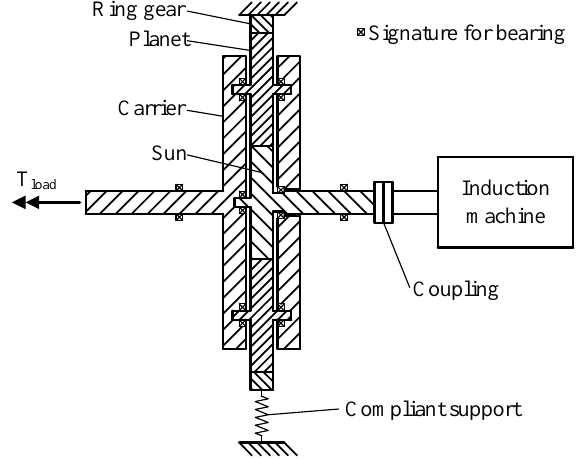
Figure 1: Considered system consisting of induction machine, gear-box and rolling-element bear-